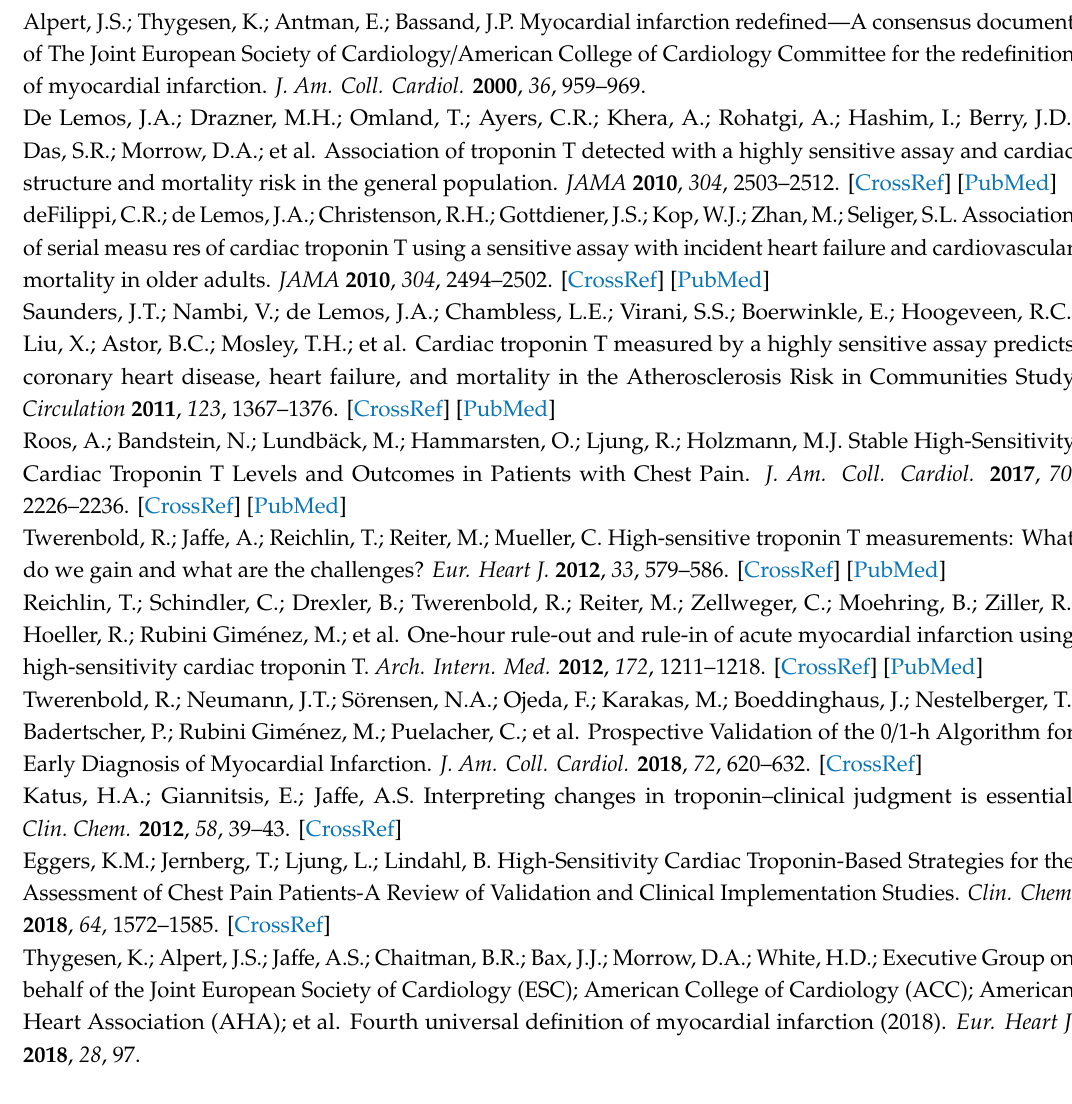
Figure S1: ROC Curve for hs-TnT for prediction of in-hospital mortality, AUC =